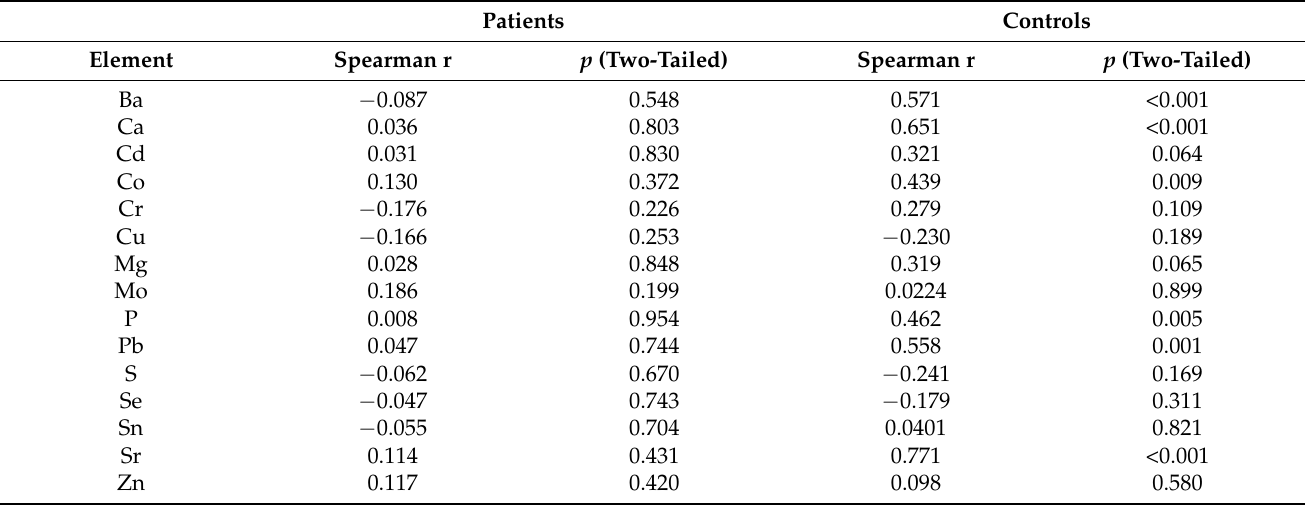
Table 4. Spearman’s rank correlation between age of donors and content of metals and trace elements